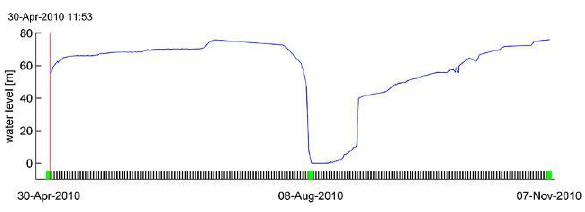
Figure 13. Water level variations at Lago Nef Norte between 30.3. and 7.11.2010